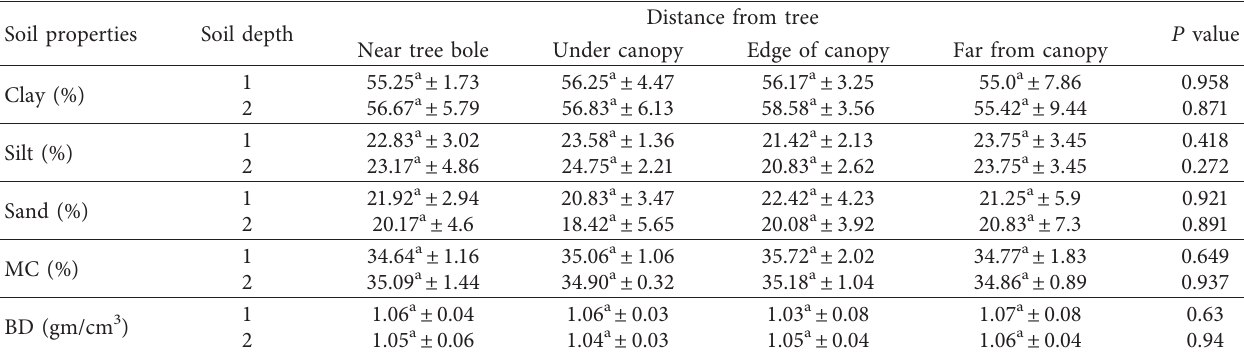
Table 2: Mean values ( ± SD) of selected soil physical parameters under soils in different distances from trees and two soil depths in Acacia seyal parkland